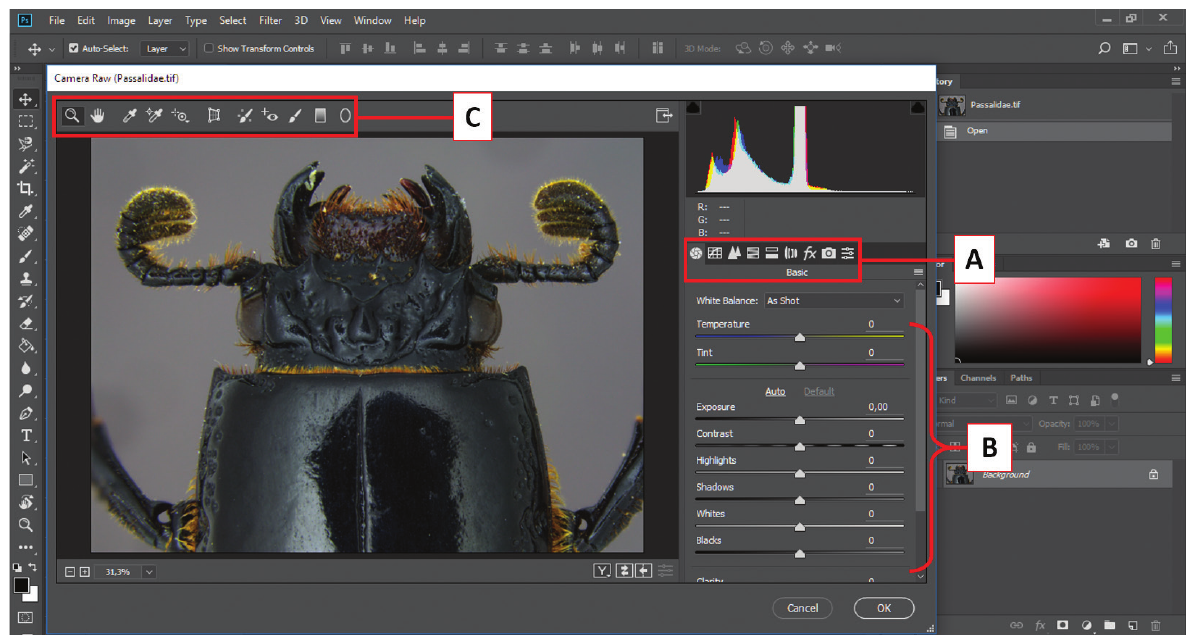
Figure 6. Camera Raw dialogue box. A . Image adjustment tabs; B . Adjustment sliders; C . General Tools